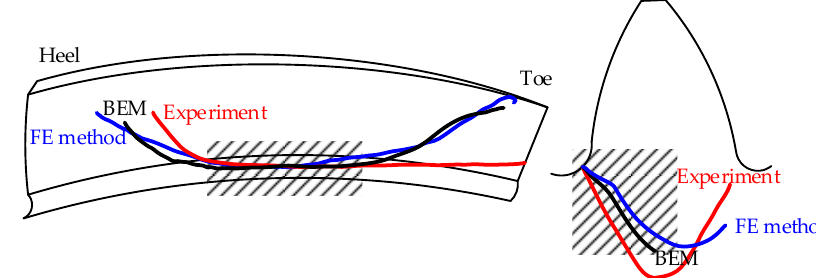
Figure 6. Bevel pinion crack propagation path [6].